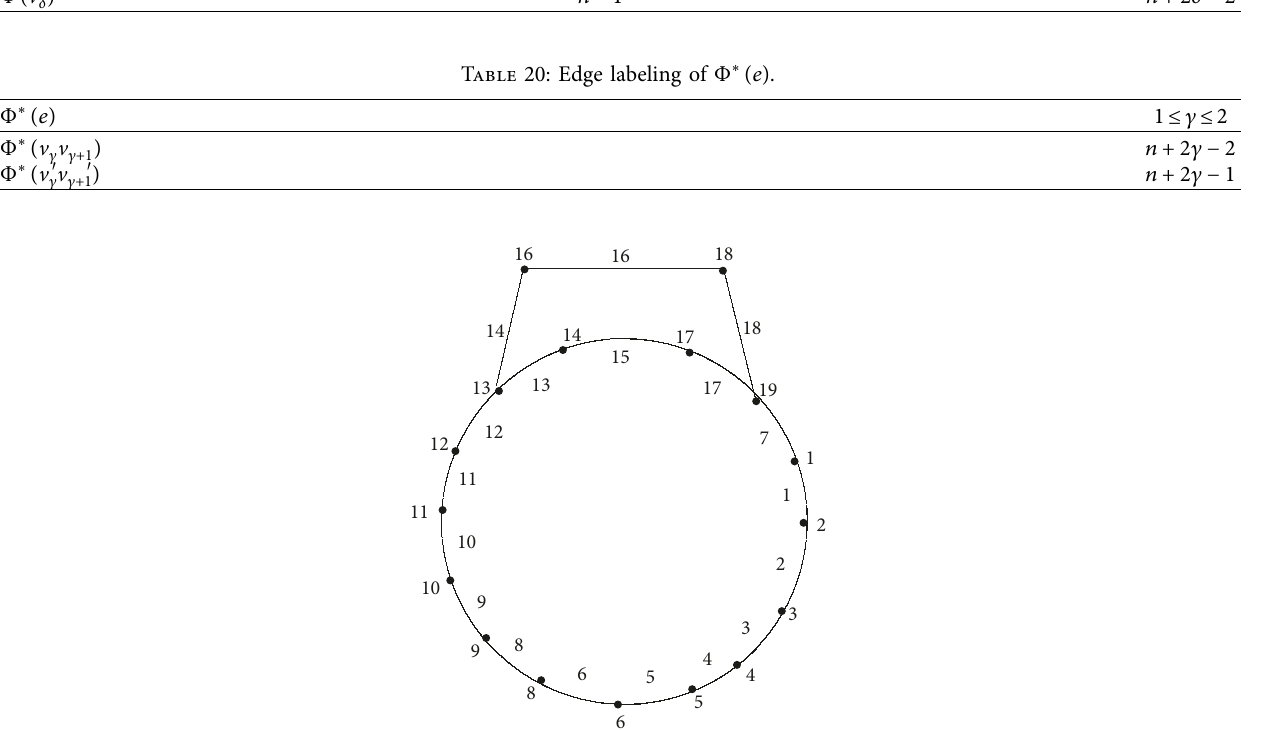
Figure 5: A classical mean labeling of the graph obtained by duplicating an edge of a graph C